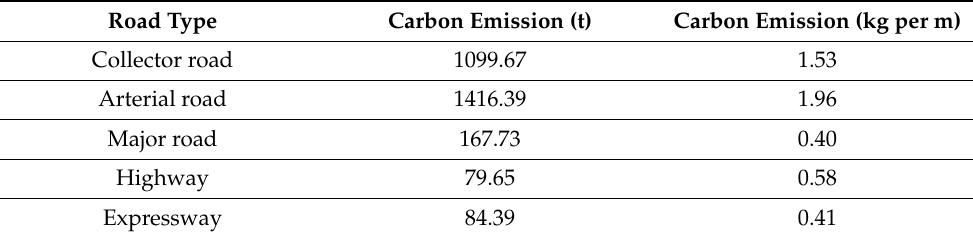
Table 5. Carbon emission factor per unit of road.